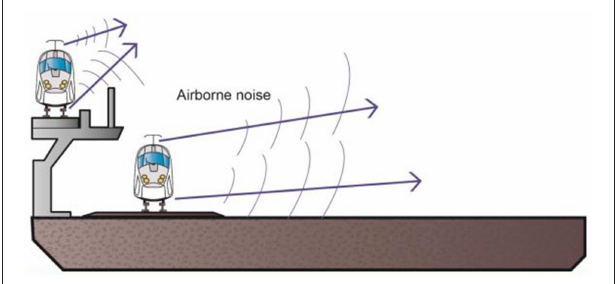
FIGURE 3 | Direct environmental airborne noise from HSR. Source: (Temple-ERM, 2013).